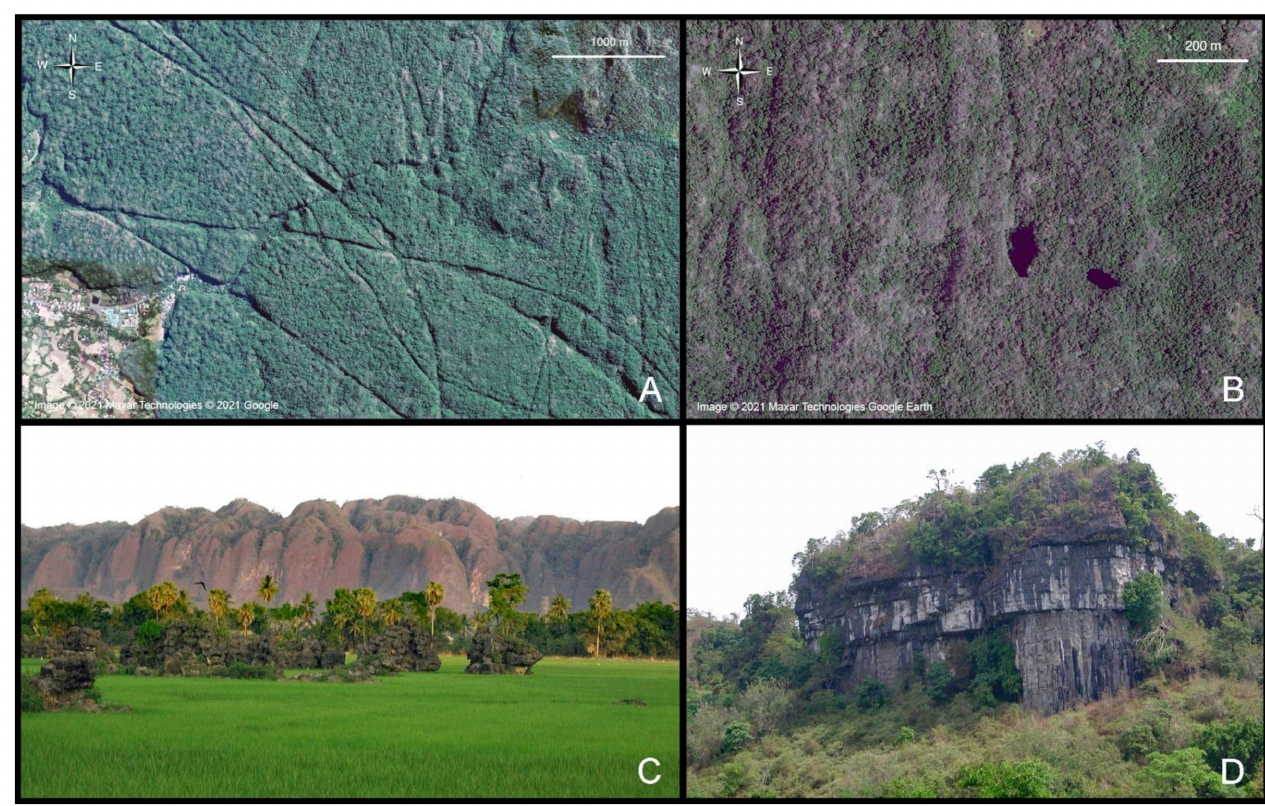
Figure 1. Karst landscape of the Maros karst; ( A ) corridors generated by volcanic dykes in the Towakkalak area (Google Earth); ( B ) Batuputte giant shafts (Google Earth); ( C ) limestone cliffs NW of Bantimurung (Leang Leang valley); ( D ) volcanic sill topped with limestone near Pangea. Reproduced with permission from Louis Deharveng ( C , D